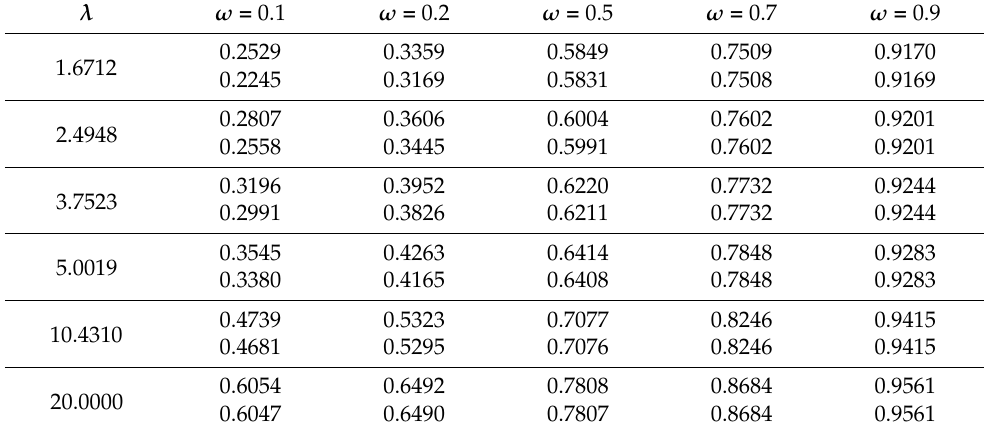
R ω ( T J . S ( (cid:107) Y (cid:107) 2 ) , µ ) R ω ( T J . S + ( (cid:107) Y (cid:107) 2 ) , µ ) and for d = 20 and ω = 0.1, 0.2, R ω ( T 0 , µ ) R ω ( T 0 , µ )